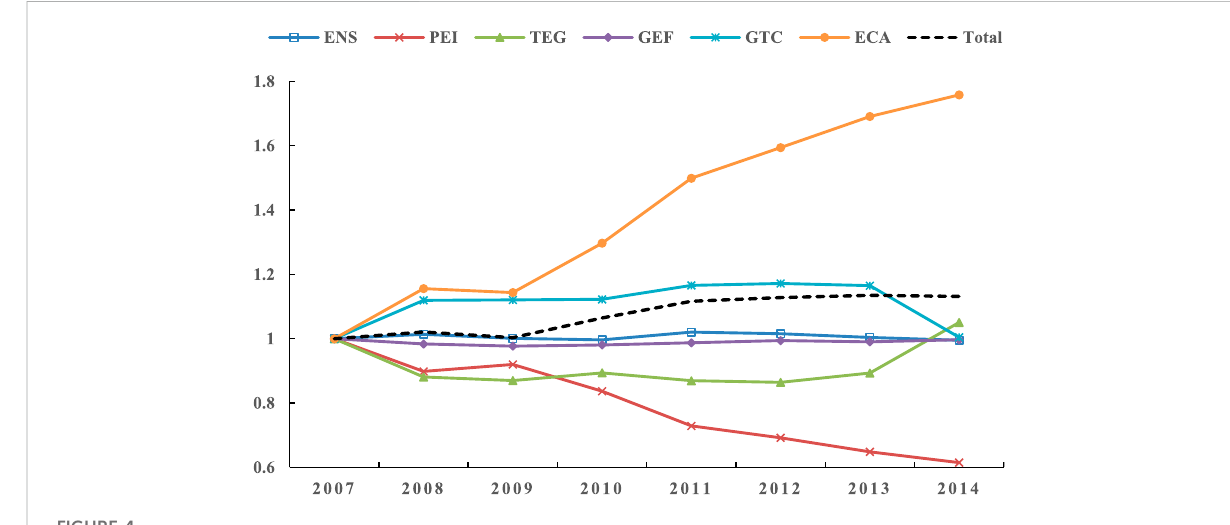
FIGURE 4 Cumulative changes of sample countries ’ carbon intensity and its decomposition, 2007 –